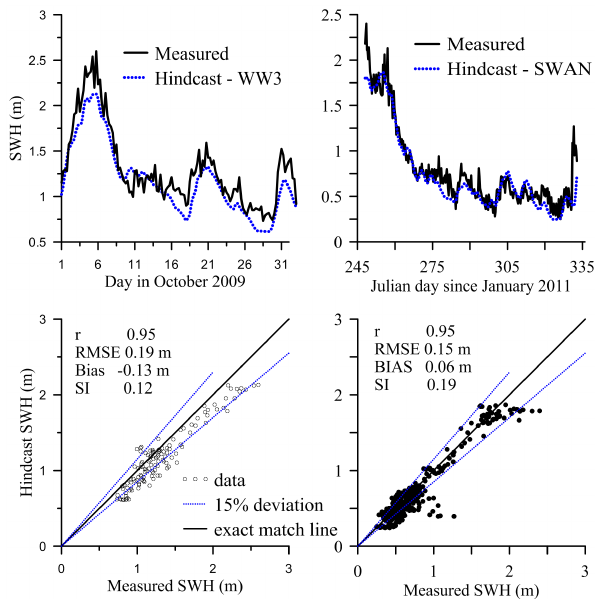
Figure 3. Comparison of hindcast SWH values with measured val- ues. Left panel shows the values during October 2009 at deep-water location and the right panel shows the values during September– November 2011 at shallow-water location (Ratnagiri).